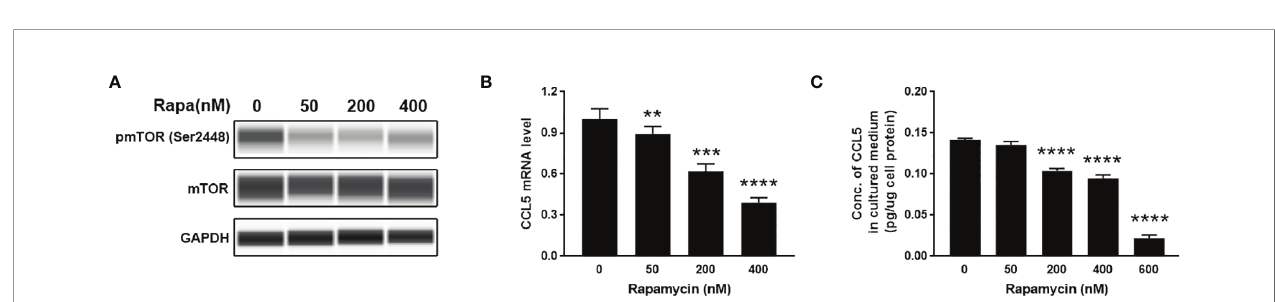
FIGURE 3 | Release of CCL5 from microglia is attenuated by the mTOR inhibitor. HMC3 cells were treated with rapamycin (Rapa, 0-600nM) for 48 h, and the activity of mTOR signaling and expression of CCL5 were assessed. (A) The total and phosphorylated levels of mTOR were analyzed by Western blotting with GAPDH as loading control. (B) The mRNA expression level of CCL5 was determined by qRT-PCR with or without rapamycin treatment (n=3 each group). (C) Release of CCL5 was measured from cell culture supernatants by quantitative ELISA test (n=3 each group). Data are presented as mean ± SD. Signi fi cance of differences between cells treated with and without rapamycin was determined by Student- t test and denoted by ** p < 0.01, *** p < 0.001, and **** p <